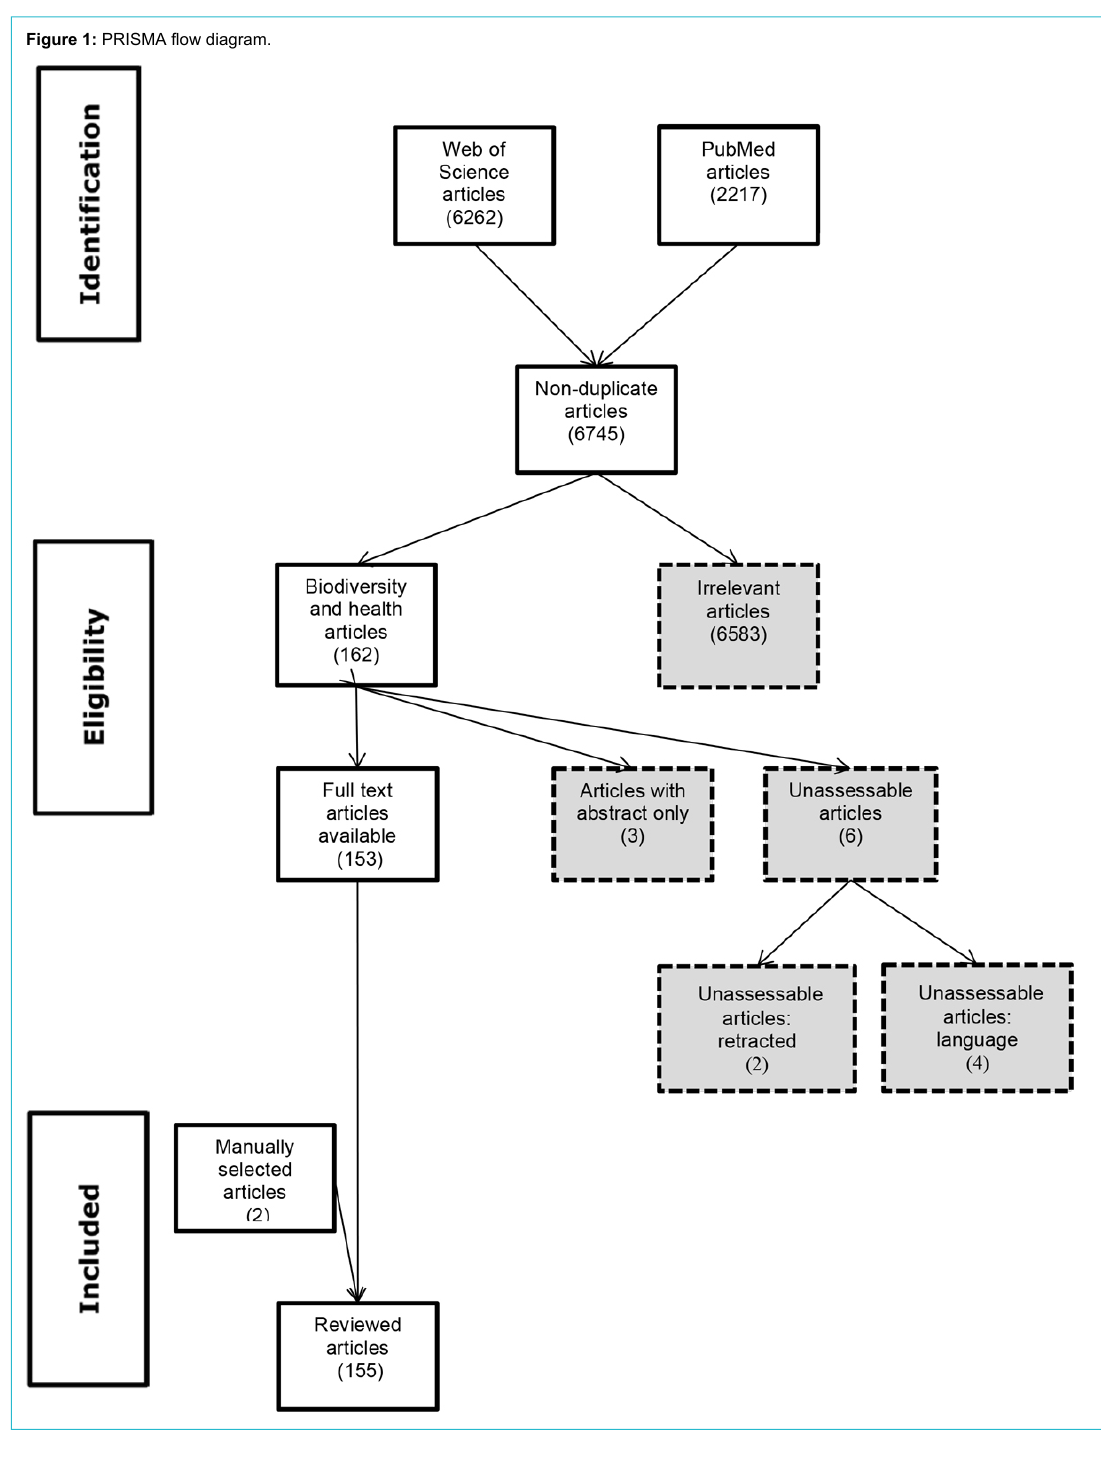
Figure 1: PRISMA flow